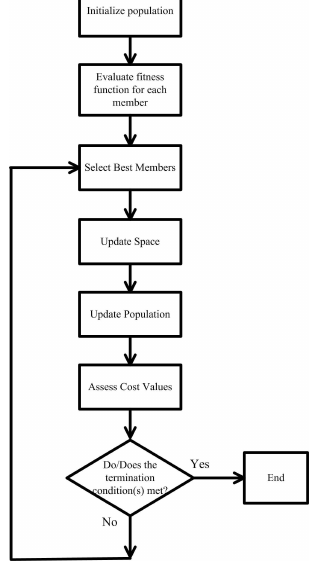
Figure 6. Flow-diagram of cultural